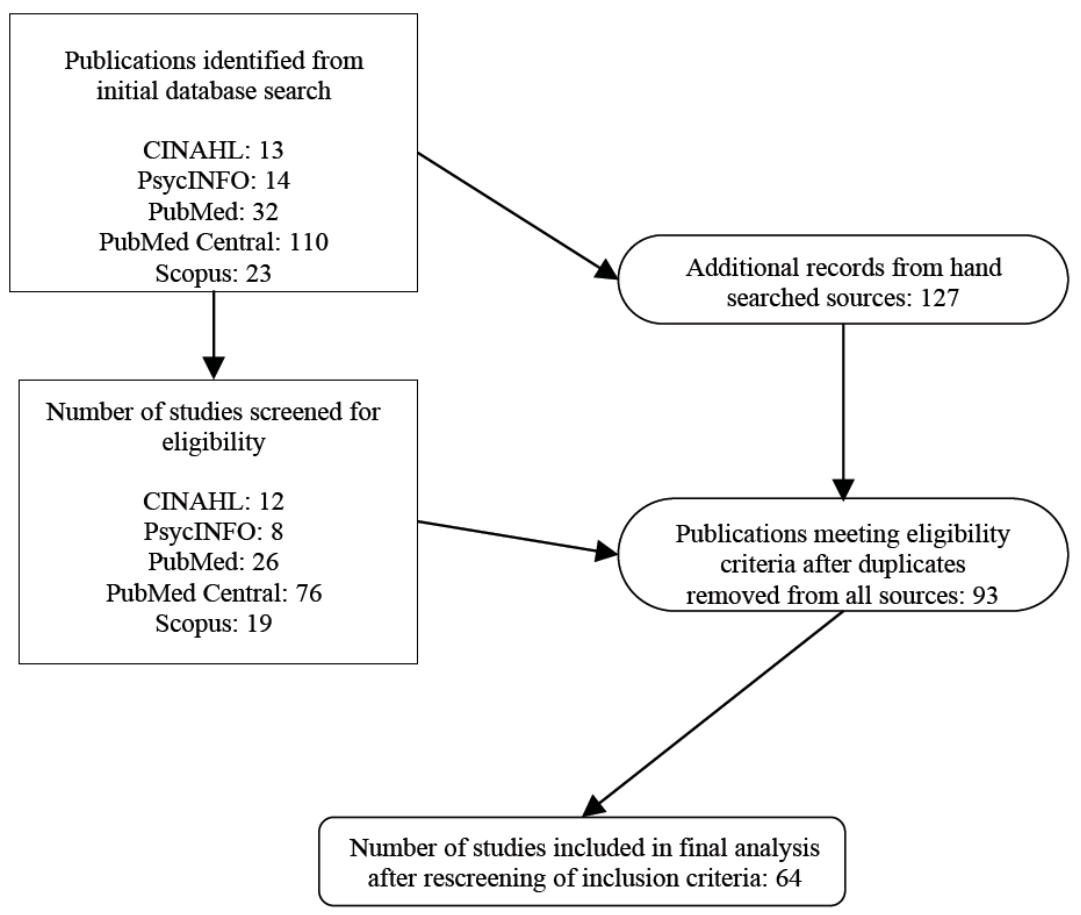
Figure 2. Literature search process.